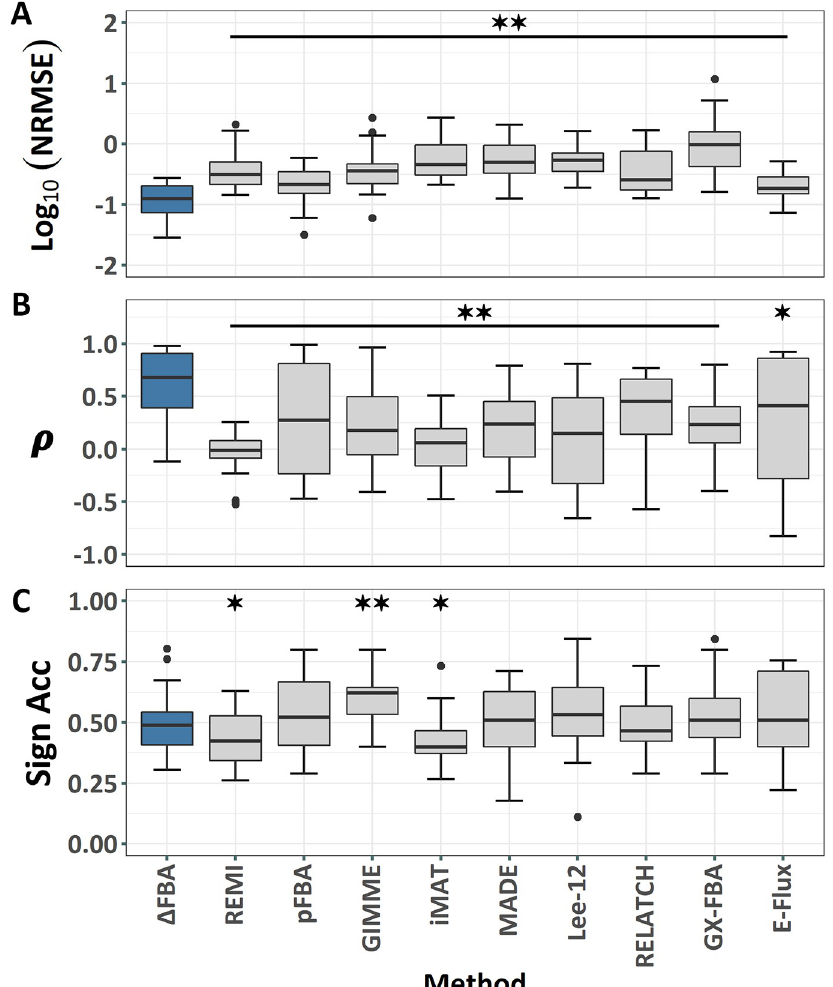
Fig 1. Comparison of the performance of Δ FBA and 9 comparative FBA methods, including REMI [31], parsimonious FBA (pFBA) [19], GIMME [20], iMAT [21], MADE [22], E-Flux [23], Lee et al . [24], RELATCH [25], and GX-FBA [26], in predicting E . coli metabolic response to environmental (dilution rates) and genetic (single gene deletions) perturbations in the Ishii et al . [35] study. (A) Normalized Root Mean Square Error (NRMSE) of the predicted flux differences; (B) Uncentered Pearson’s Correlation Coefficient ( ρ ); and (C) Sign Accuracy (Sign Acc) between the predicted and measured flux differences. Statistical significance was done using two- sided paired t -test. ✶ indicates p -value < 0.05 and ✶✶ indicates p -value < 0.01.